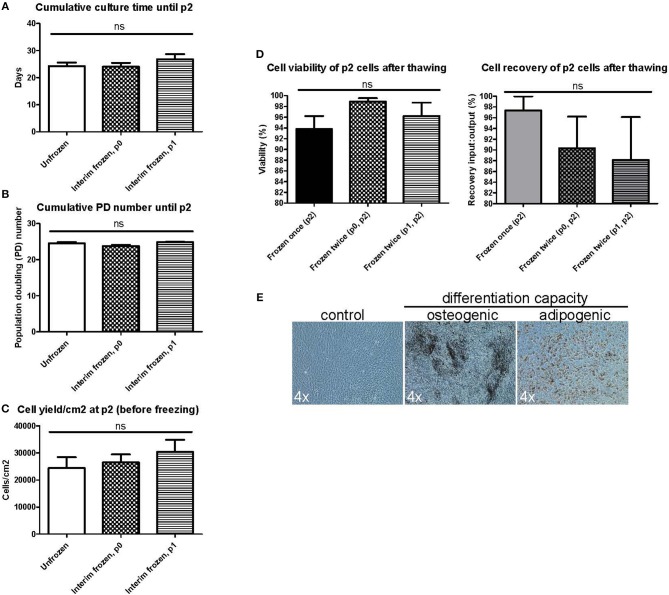
Manufacturing parameters and characterization of BM-MSCs in passage 2 after two freezing steps. MSC products in passage 2 (p2) are compared after no preceding freezing steps (unfrozen), one freezing step at passage 0 (p0) or one freezing step at passage 1 (p1). (A) Cumulative culture time at p2. (B) Cumulative population doubling (PD) time. (C) Cell yield per cm2 at p2 before freezing. (D) Cell viability (left) and cell recovery (right) at p2 after freezing and thawing. (E) Osteogenic and adipogenic differentiation capacity of MSCs frozen twice in either p0 or p1 and p2. Representative phase contrast microscope pictures presented from n = 3. Enlargement indicated for each picture separately. Results in (A–D) are presented as mean ± SEM (n = 4).